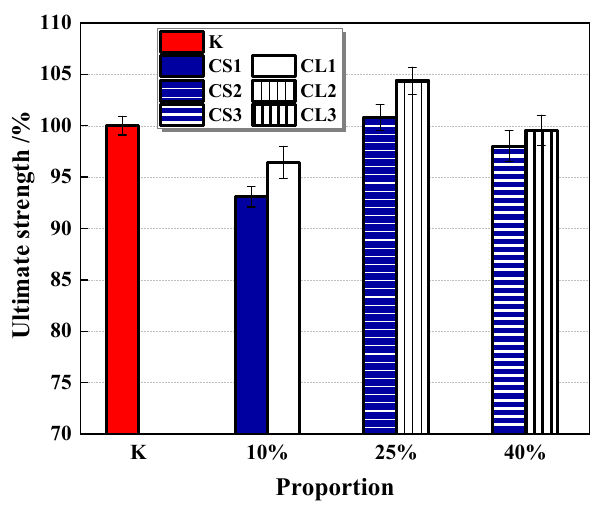
Figure 16. Flexural strength of cement mortar. Error bars indicate relative standard uncertainty in experimental measurements.